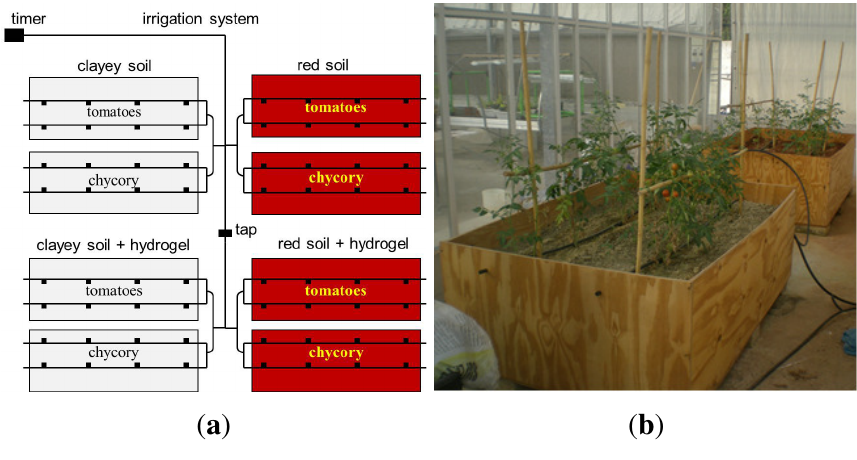
Figure 2. Schematization of the disposition of the boxes. A tap was used to reduce the amount of water delivered to the “soil plus SAP” boxes ( a ); Picture of the experimental setup ( b